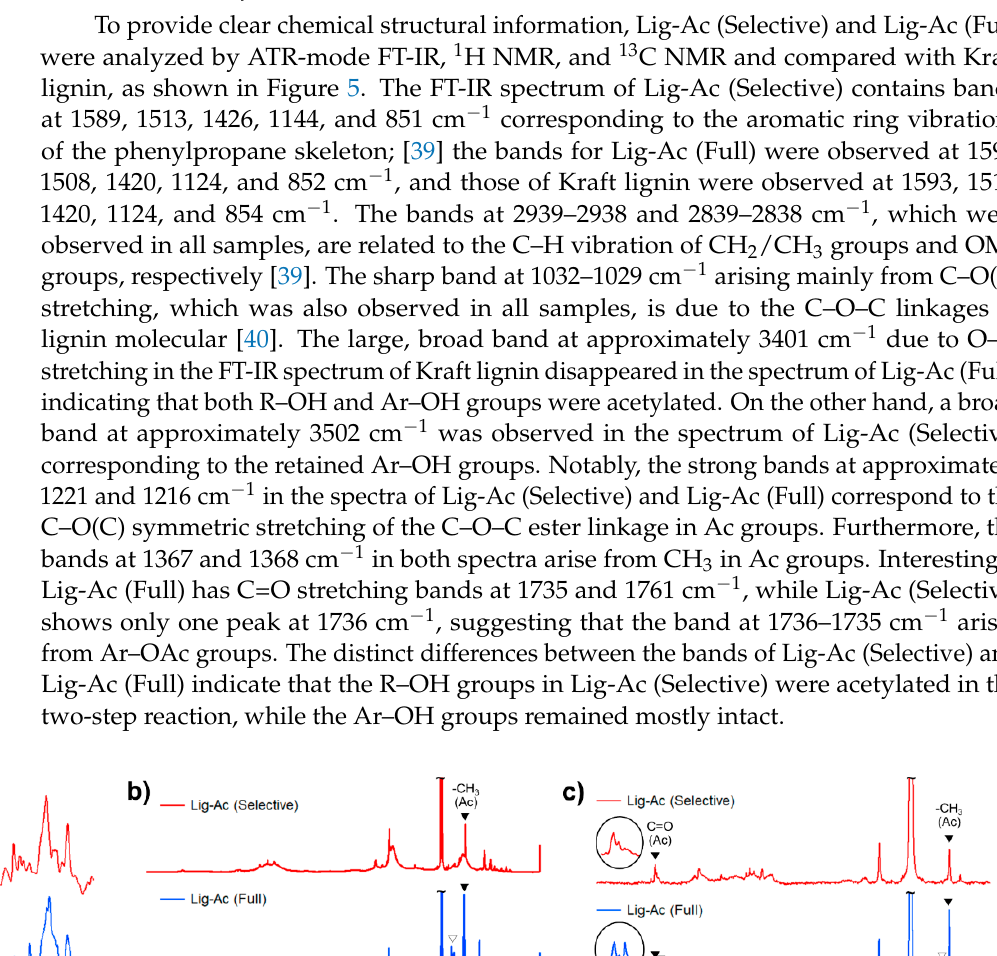
Table 2. Solubilities of Kraft lignin and acetyl derivatives. Solvent